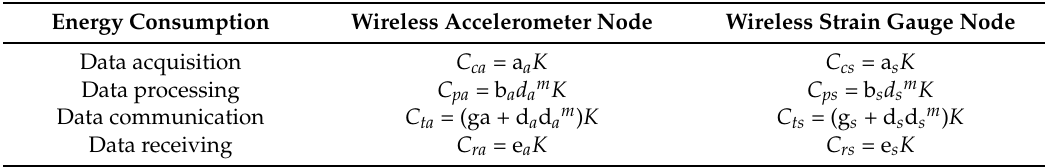
Table 1. The energy consumption functions of each unit about different sensor nodes.